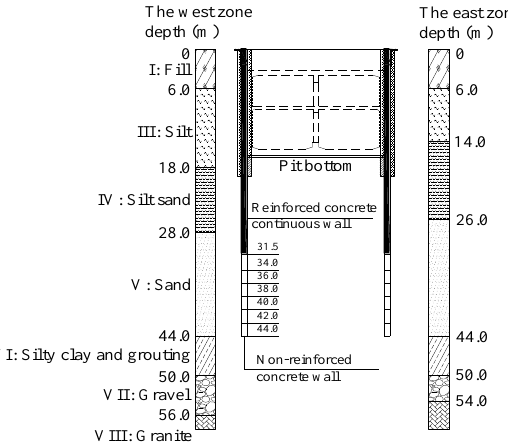
Figure 11. Strata generalization and designed curtain schemes.